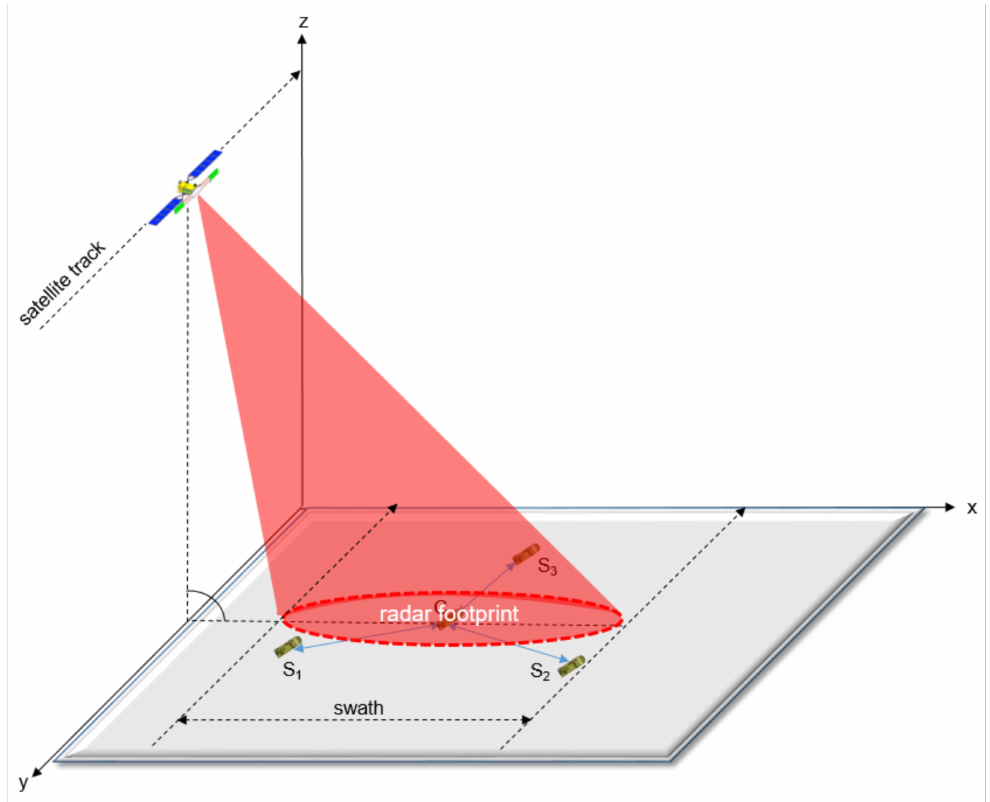
Figure 5. General configuration of ESM MLAT system.